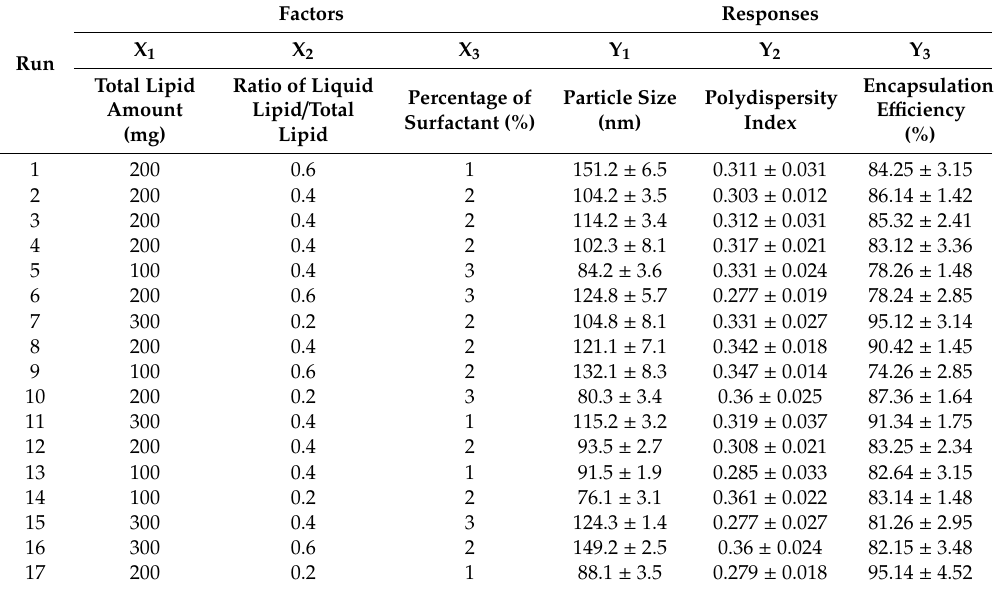
Table 3. Experimental design and actual responses of Box–Behnken design. Data are expressed as mean ± SD (n = 3).